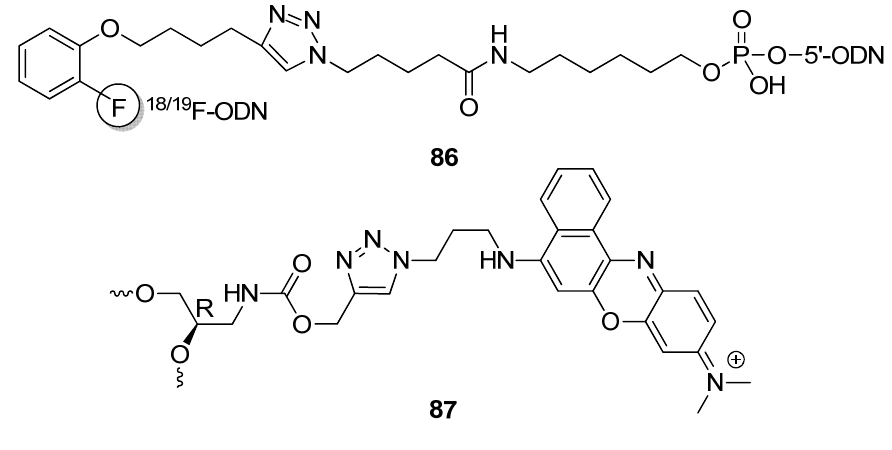
Figure 14. Examples of spin-labels and fluorescent residues linked to oligonucleotides through triazole